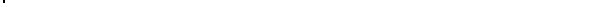
Table 2. Brain regions showing signi fi cant changes in dorsolateral prefrontal resting-state functional connectivity after active vs. sham stimulation (active stimulation (post-pre) > sham stimulation (post- pre) contrast).